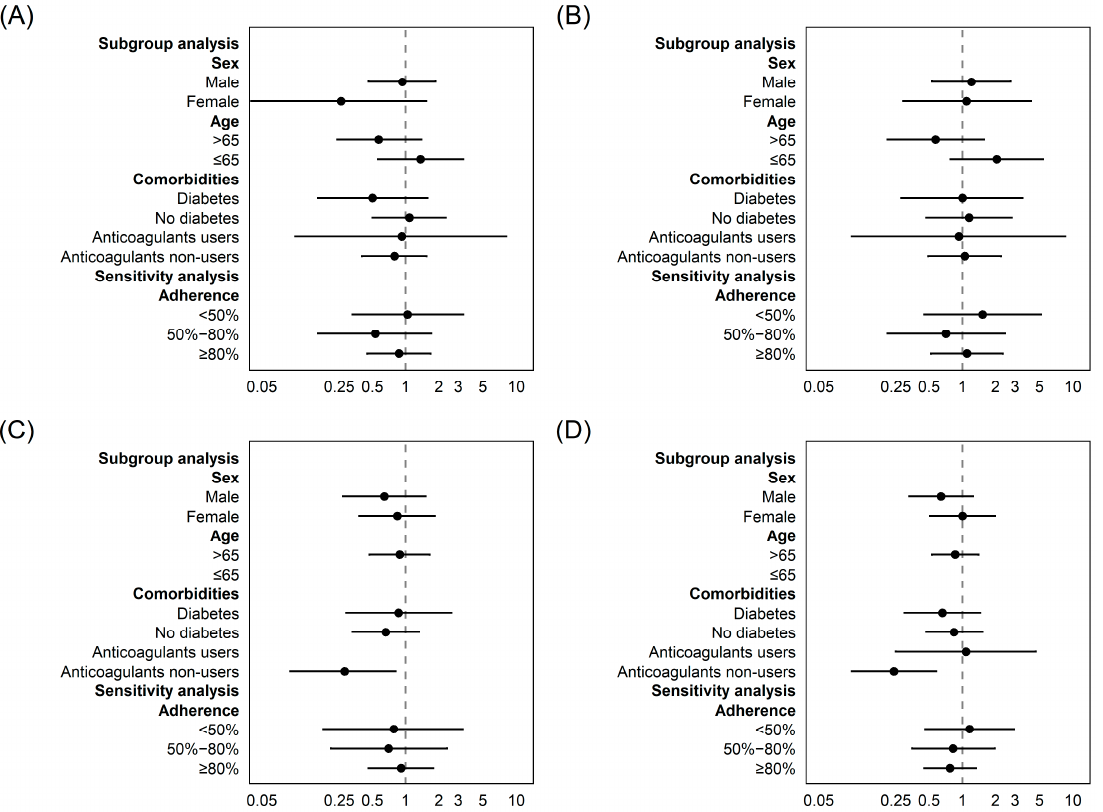
Figure 2. Subgroup and adherence analyses of ICU access risk ( A ), need of mechanical ventilation risk ( B ) and 14day ( C ) and 30-day ( D ) all-cause mortality in CVDs patients that tested positive for SARS-CoV-2 and were hospitalized. Legend: For anticoagulant-use group in panel ( C ) and ≤ 65 years group in ( C , D ), the estimation was not allowed due to absence of data.